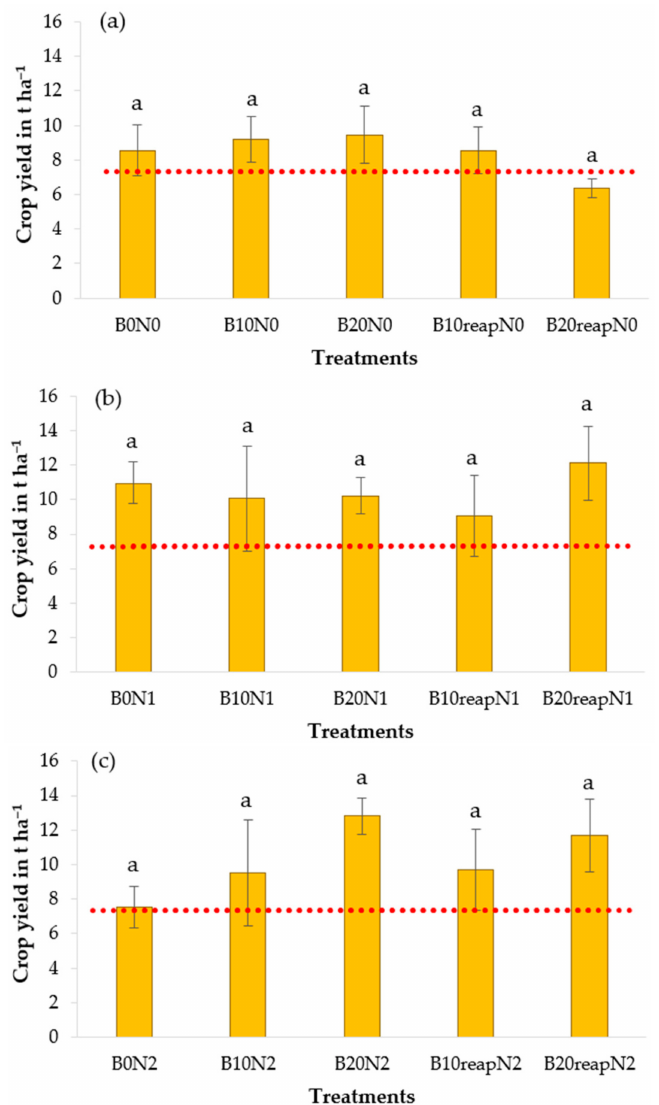
Figure 6. Maize grain yield in the treatments with and without biochar at unfertilized level N0 ( a ), and fertilized levels N1 ( b ) and N2 ( c ). Error bars denote the standard errors of the mean ( n = 3). Different letters in the graph indicate significant differences between different treatments according to the Tukey procedure ( p < 0.05). Dotted line delineates the average maize yield in Slovakia in